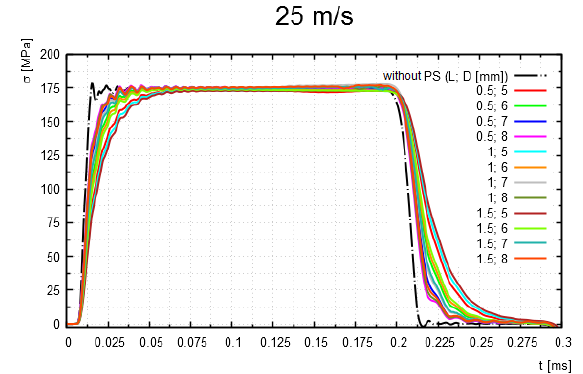
Figure 11. Influence of the diameter of the